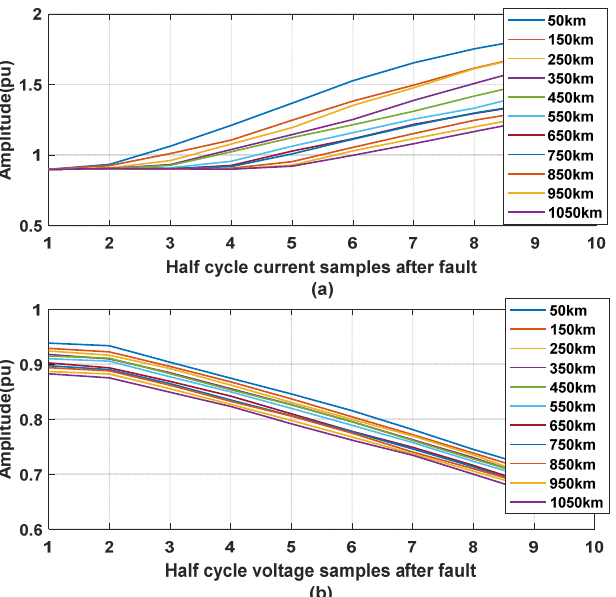
Figure 4. ( a ) Half cycle rms current and ( b ) Half cycle rms voltage during P1G fault at various locations.